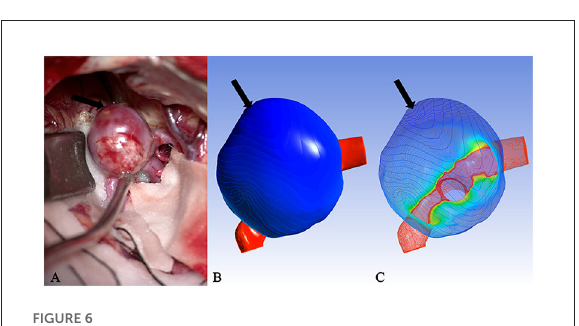
FIGURE6 Case 15: (A) An unruptured aneurysm in the middle cerebral artery. The volume was listed as “outlier.” (B) The cloud image was uniformly stained. (C) The isolines near the minimum extreme point were arranged regularly and evenly spaced. It was speculated that this was also one of the reasons why some aneurysms did not rupture despite the large volume.